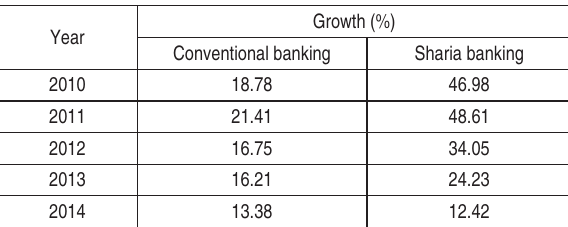
Table 1. Growth rate of conventional and Sharia